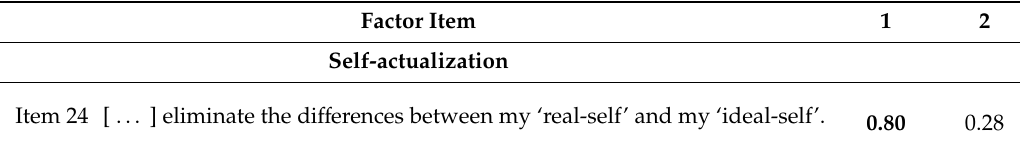
Table 4. Factor loadings and total variance explained from the rotated factor structure of the ISR-SES ( N =